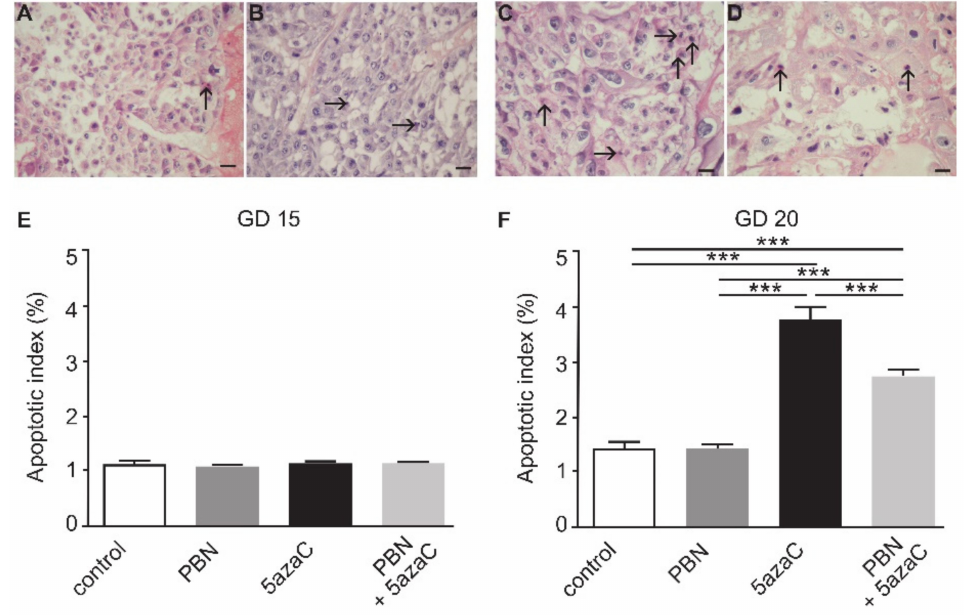
Figure 3. Apoptosis in rat placentas. Representative micrographs of apoptotic cells (arrows) in the basal layer of placentas isolated on GD 15: control ( A ), 5azaC-treatment ( B ). Placentas isolated on the GD 20: control ( C ), 5azaC-treatment ( D ). Hematoxylin and eosin, scale bar 25 µ m. Apoptotic index GD 15 ( E ), GD 20 ( F ). ANOVA, *** p <